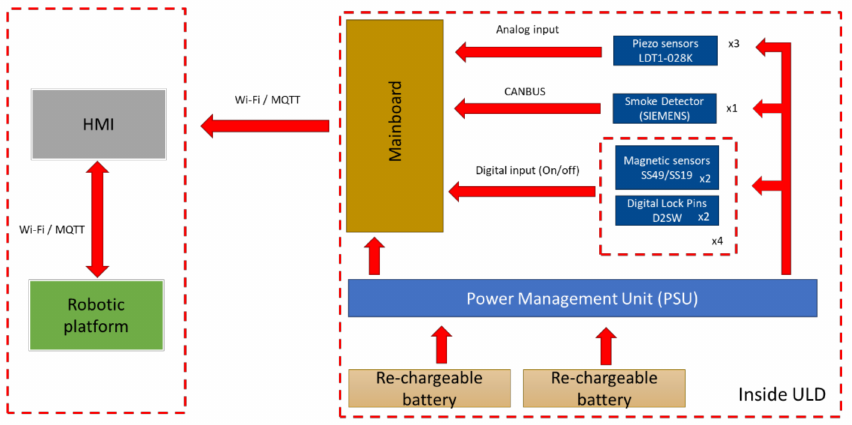
Figure 2. The INTELLICONT system hardware architecture, its main components, and the communi- cation between them.